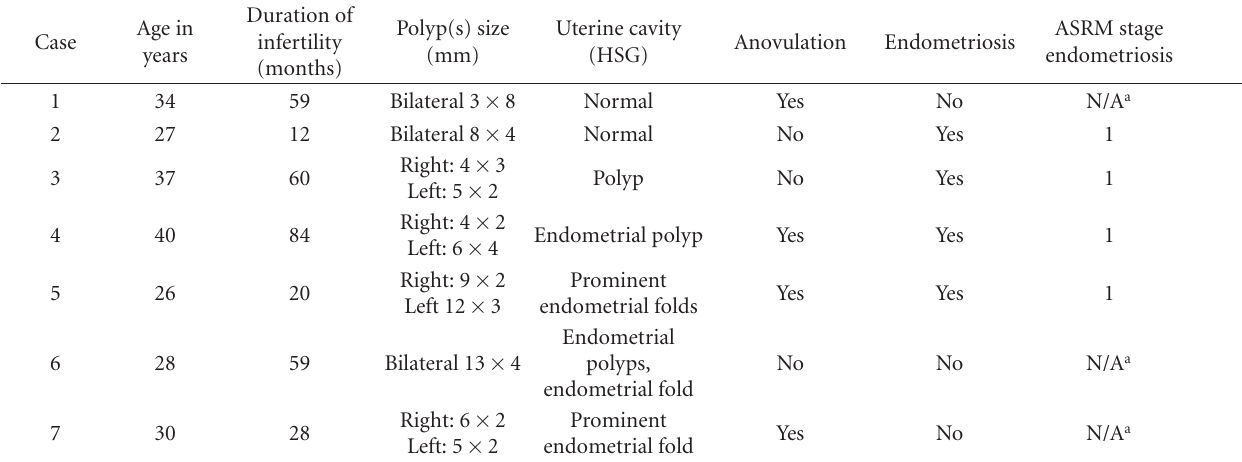
Table 1: Clinical characteristics of infertile women with large cornual polyps.